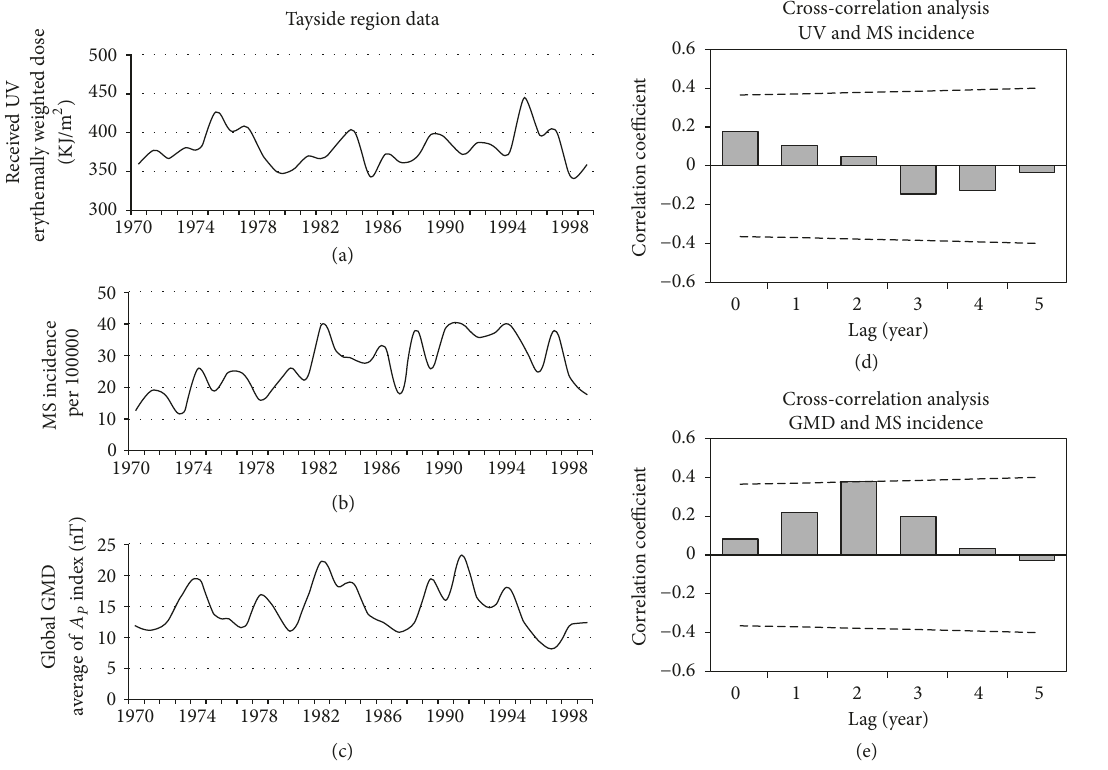
Figure5:Taysideregiondata.Panel(a):annualaverageofthereceivedUV(1970–99).Panel(b):MSincidenceoftheTaysideregion(1970–99), adapted from the report of Donnan et al. [14]. Panel (c): annual average of global GMD based on the 𝐴 𝑝 index (1970–99). Panel (d): the result of lagged correlation between received UV and MS incidence. Panel (e): the result of lagged correlation between GMD and MS incidence. The dashed lines in those panels (d and e) are the threshold for significant correlation. The horizontal solid lines in these panels indicate coefficient of correlation (𝑟) = 0